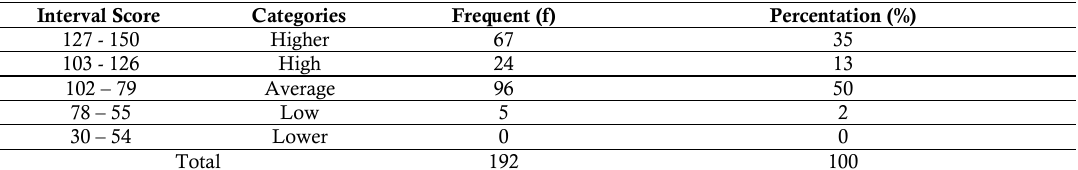
Table 3. Distribution Frequent based Score Category Learning